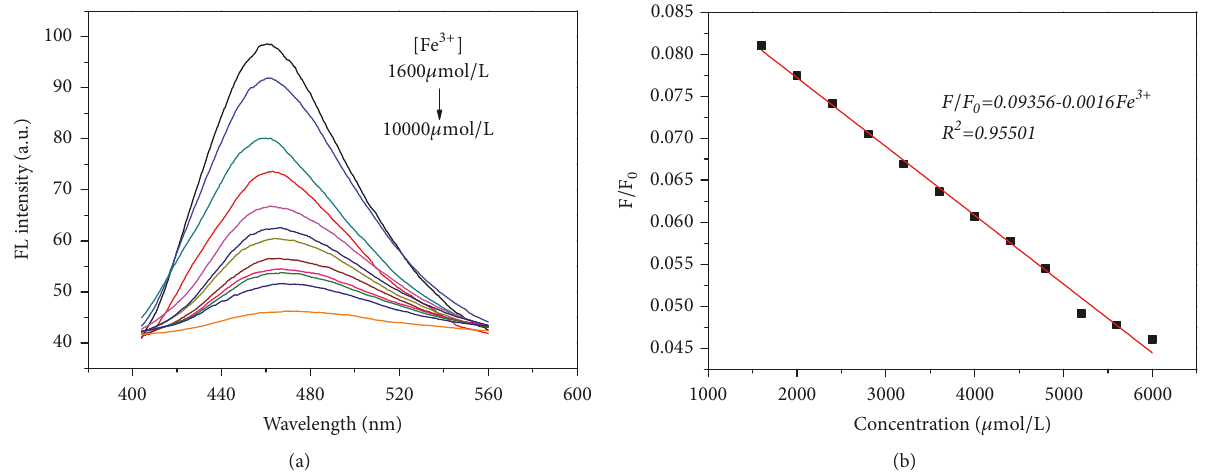
Figure 7: (a) Fluorescence spectra of iron ions with a concentration of 1600 ∼ 10000 𝜇 mol/L in the sample; (b) linear detection range of iron ions (the concentration of Fe 3+ is1600 ∼ 6000 𝜇